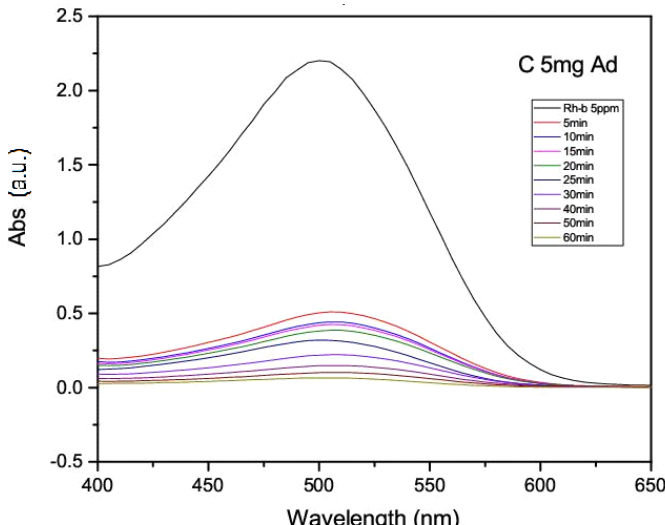
Fig. 5 UV – Visible spectra of Rh-B with C NPs at a time interval of 5 minutes from 0 to 60 minutes by adsorption studies